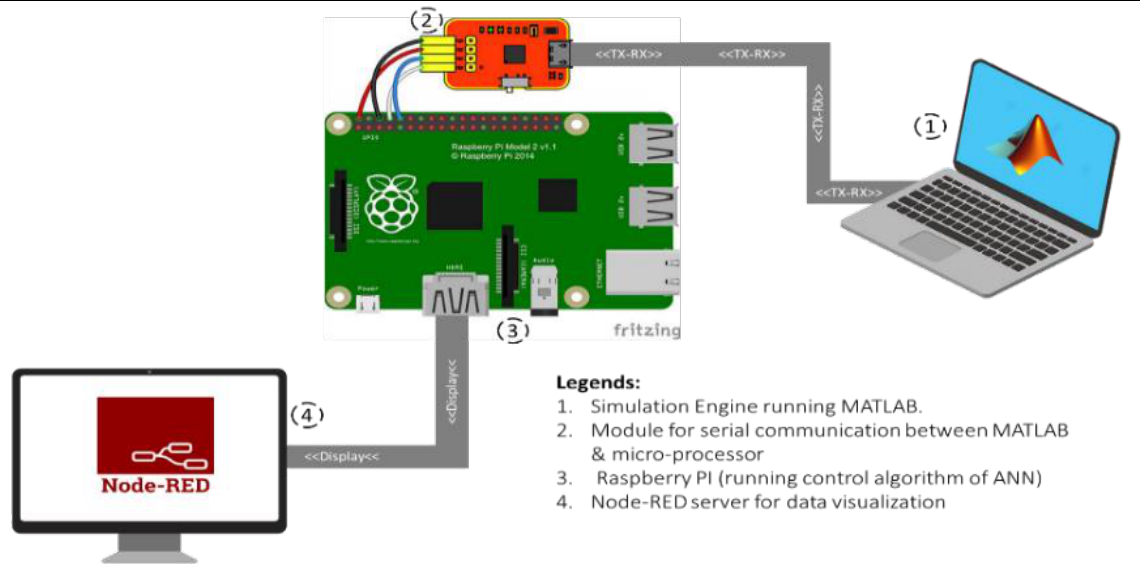
Figure 17. System Architecture for HIL with Microprocessor.